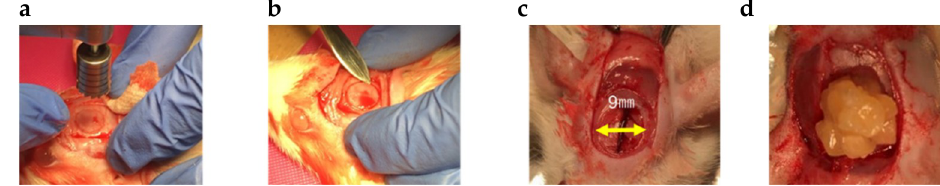
Figure 4. Procedure for sponge implantation ( a ) creation of bone defects using a trephine bar, ( b ) calvaria removal, ( c ) representative bone defects, ( d ) GS implantation.